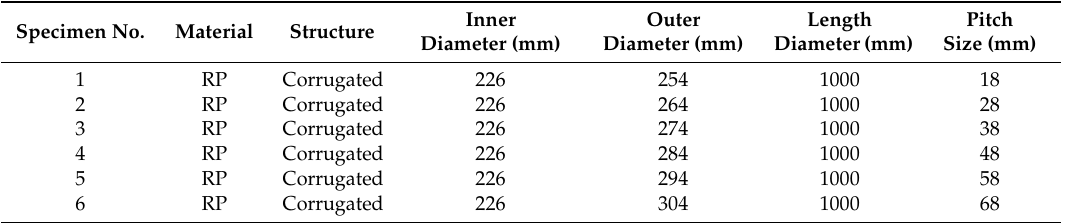
Table 3. Detailed specification of enclosure specimens used for enclosure pitch size optimization. Specimen